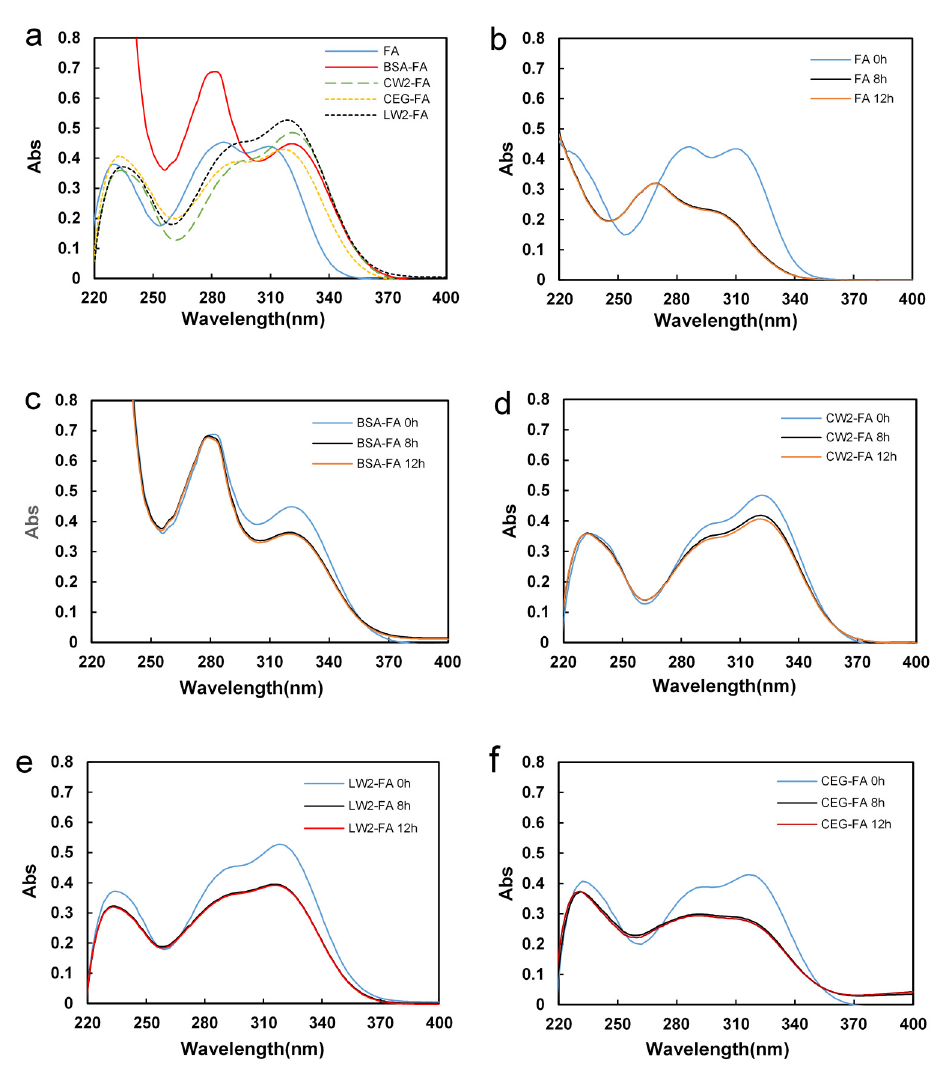
Figure 3. Time dependence of the UV absorption of each sample in the wavelength range of 220 nm to 400 nm ( a ) before UVA irradiation. ( b ) FA, ( c ) BSA-FA, ( d ) CW2-FA, ( e ) LW2-FA, and ( f ) CEG-FA.